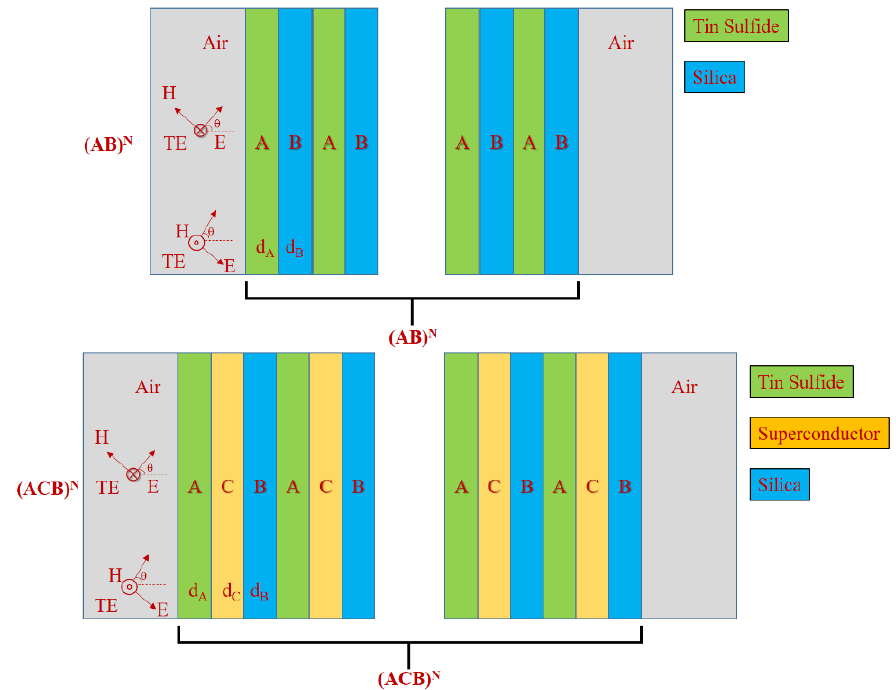
Figure 15. One-dimensional binary photonic crystal (1DBPCs) (AB) N and one-dimensional ternary photonic crystal (ACB) N representation, air is the background (Reproduced courtesy of The Electro- magnetics Academy).